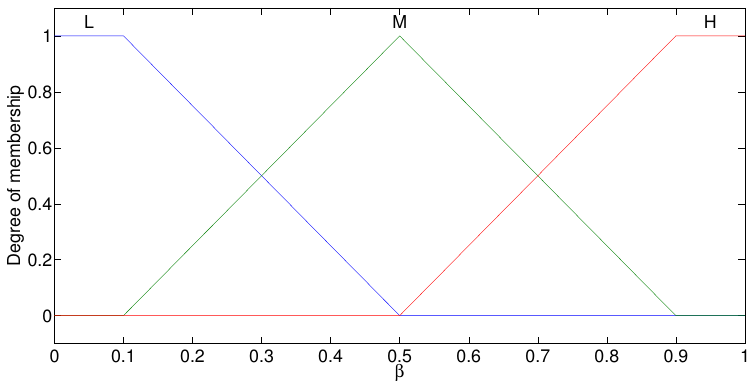
Figure 6. Membership functions of the fuzzy output β . Table 2. Fuzzy rules for FIS- β .